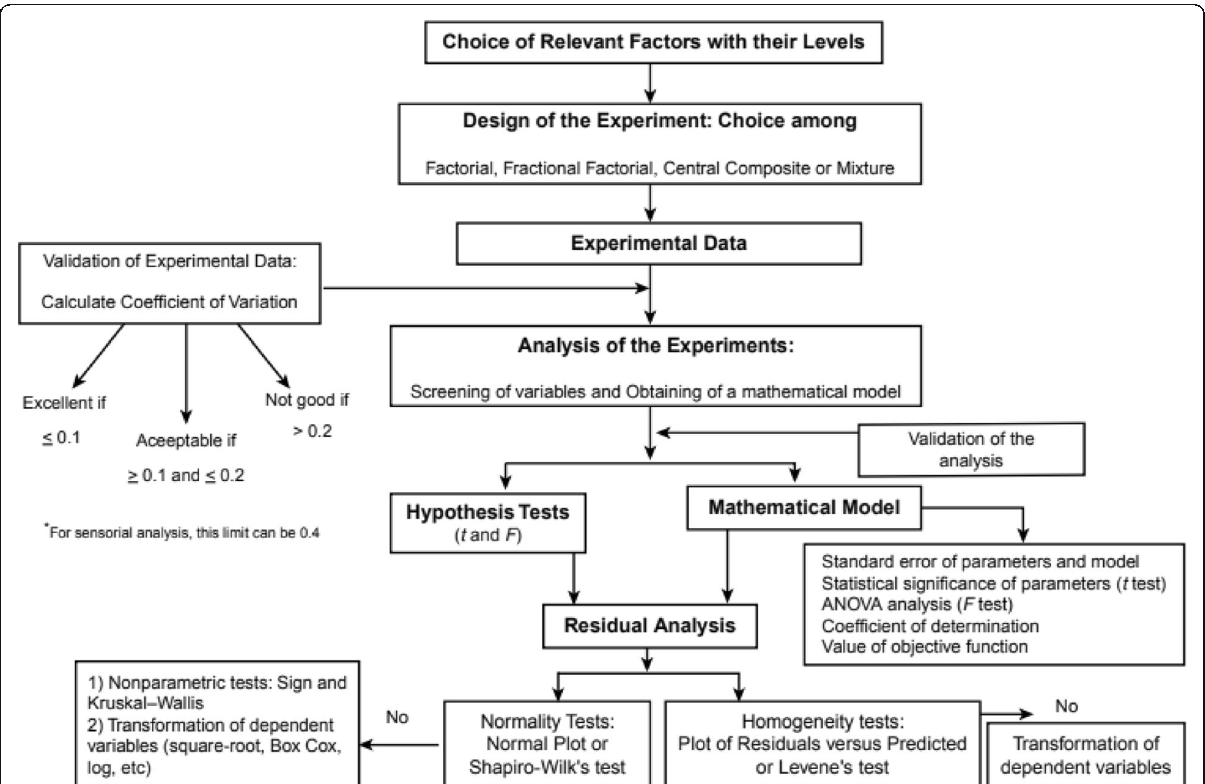
Fig. 4 Summary of the statistical procedures used to analyze the results from DOE (Granato and Calado